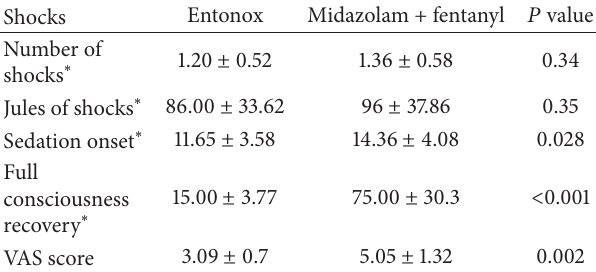
Table 2: The comparison of Entonox group with midazolam and fentanyl group regarding the need for shock, sedative, and analgesic effects (VAS: visual analogue